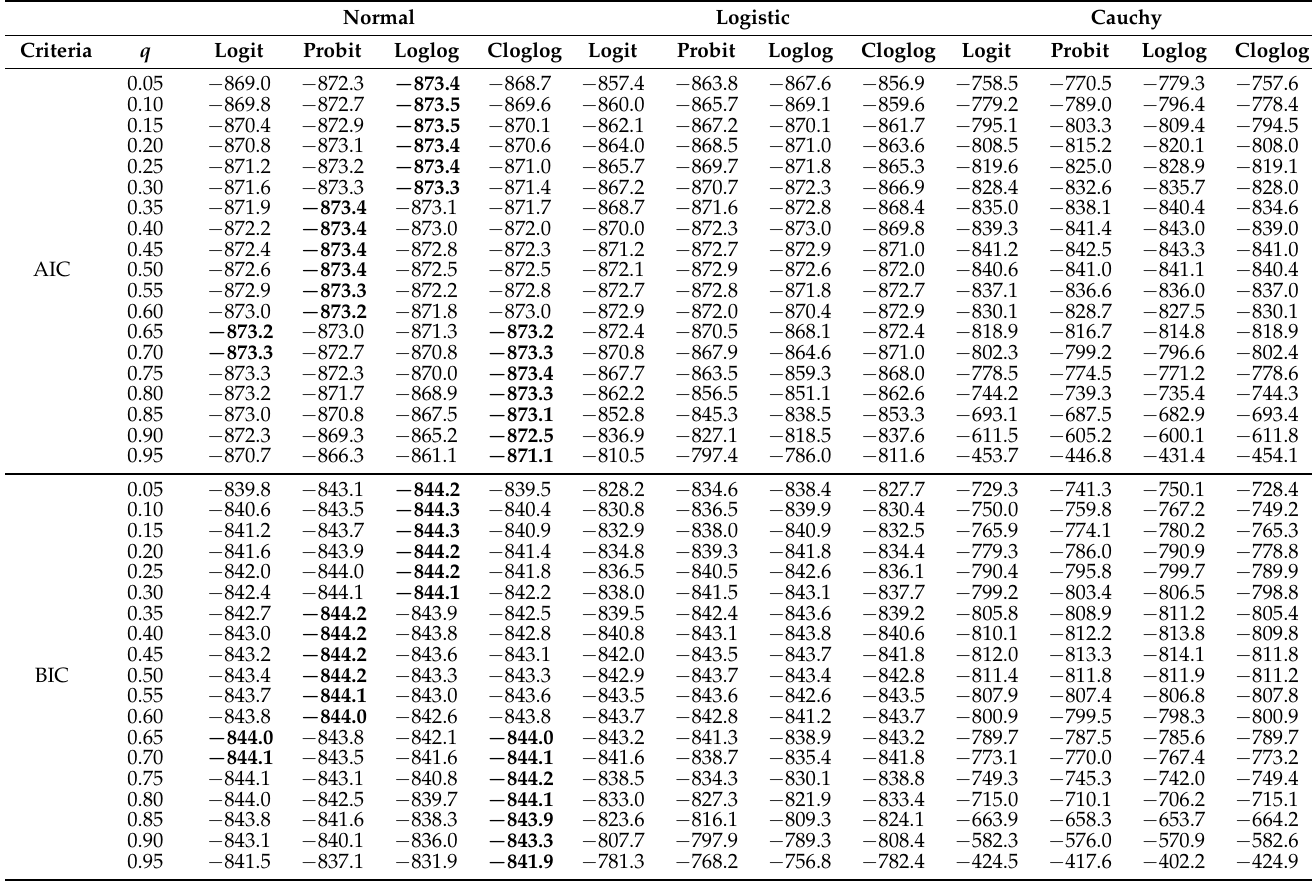
Table A2. AIC and BIC criteria for the RPGJSB2 q model of the COVID-19 data set considering 3 options for G (normal, logistic, and Cauchy) and the 4 discussed link functions.